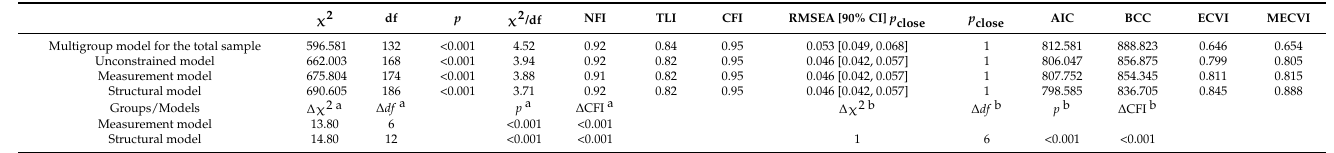
Table 3. Model Fit Indices, Models Comparison, and Summary of Invariance Tests Across Multigroup regarding compulsive buyer and not compulsive buyer.